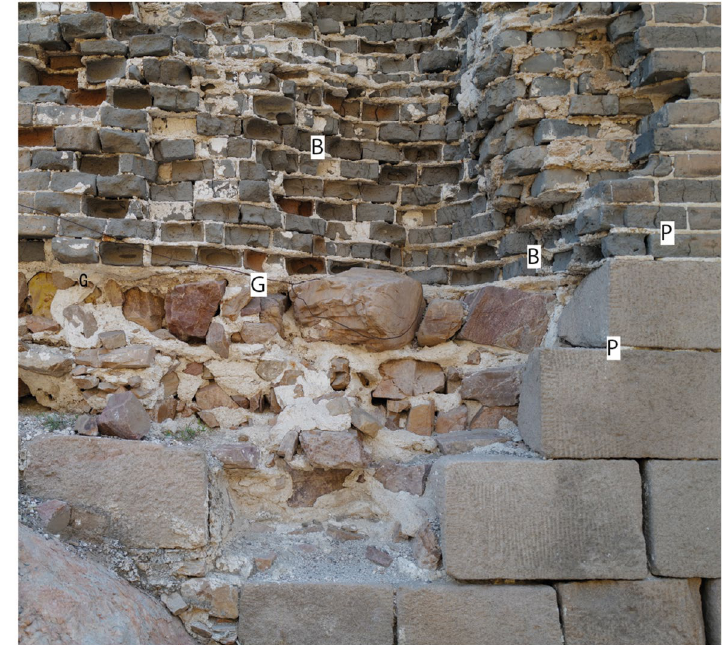
Fig. 10 Use of lime for construction of the Ming Great Wall. B: Bedding. G: Grouting. P: Pointing (Source: